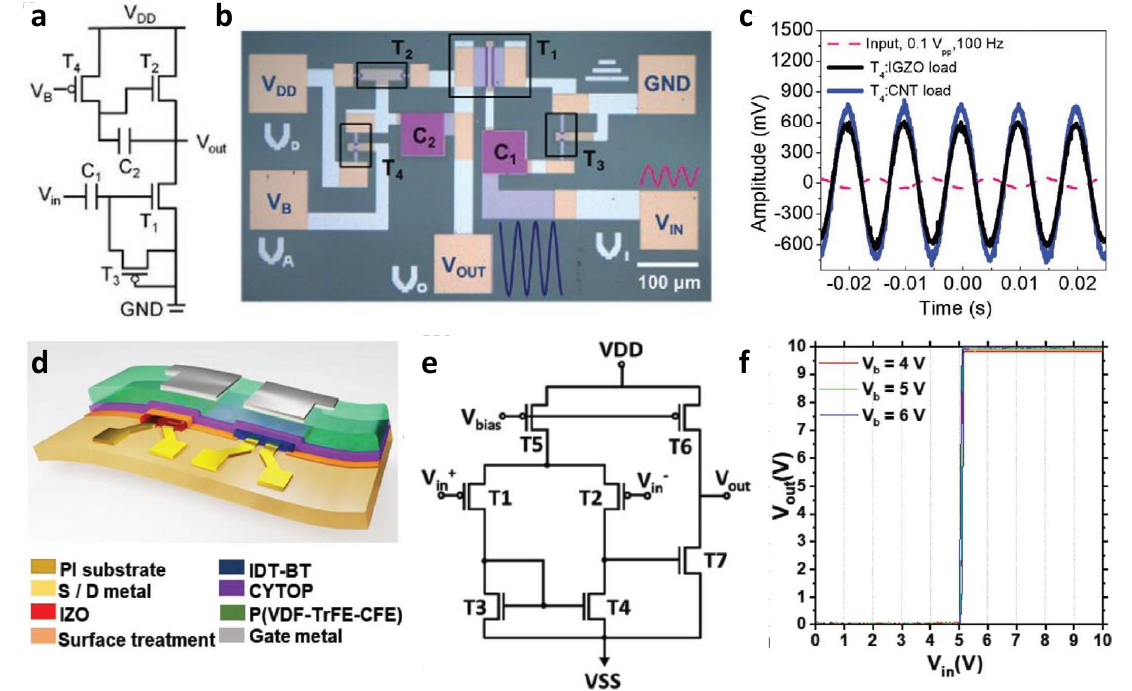
Figure 9. Metal-oxide-based thin-film analog circuits. ( a ) Circuit schematic and ( b ) optical microscopy image of a CMOS amplifier composed of IGZO and CNT TFTs. ( c ) Comparison of the input/output characteristics according to whether the load transistor was an IGZO TFT or a CNT TFT in a CMOS amplifier with the same configuration (adapted from [82] with permission from John Wiley and Sons). ( d ) Complementary circuit schematic diagram composed of IZO and IDT-BT. ( e ) The circuit diagram of a two-stage amplifier composed of IZO and IDT-BT and ( f ) the corresponding voltage transfer characteristics. (adapted from [ 83 ] with permission from John Wiley and Sons).